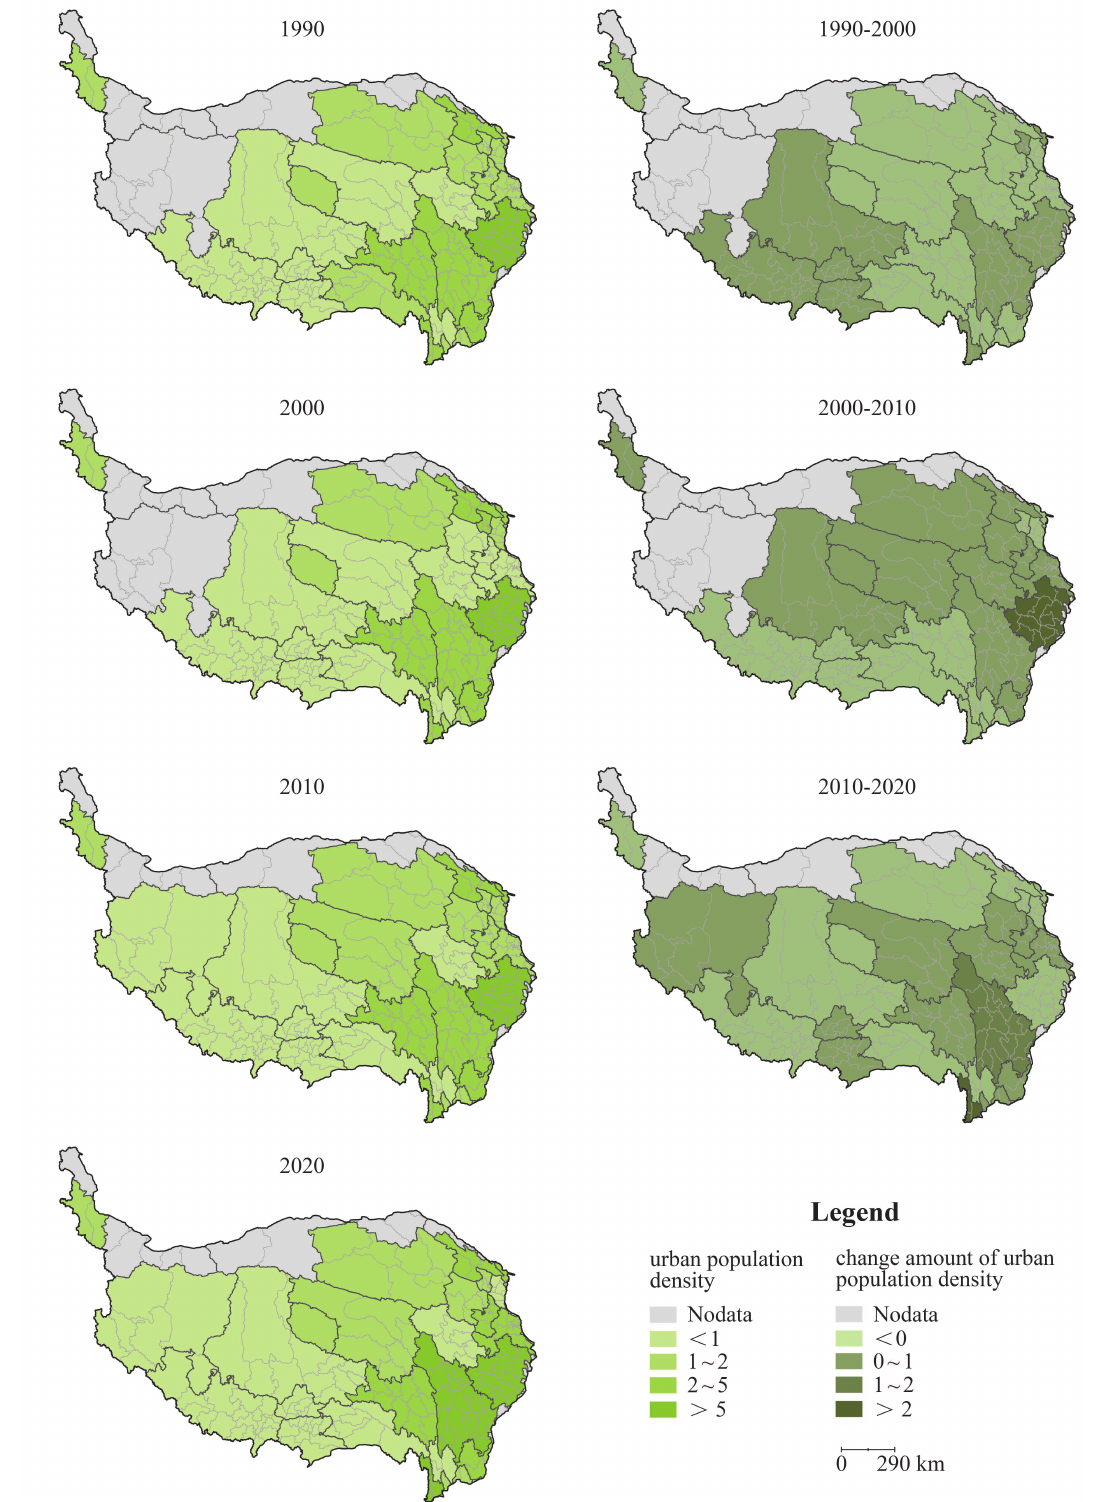
Figure 6. UPD in the Qinghai–Tibet